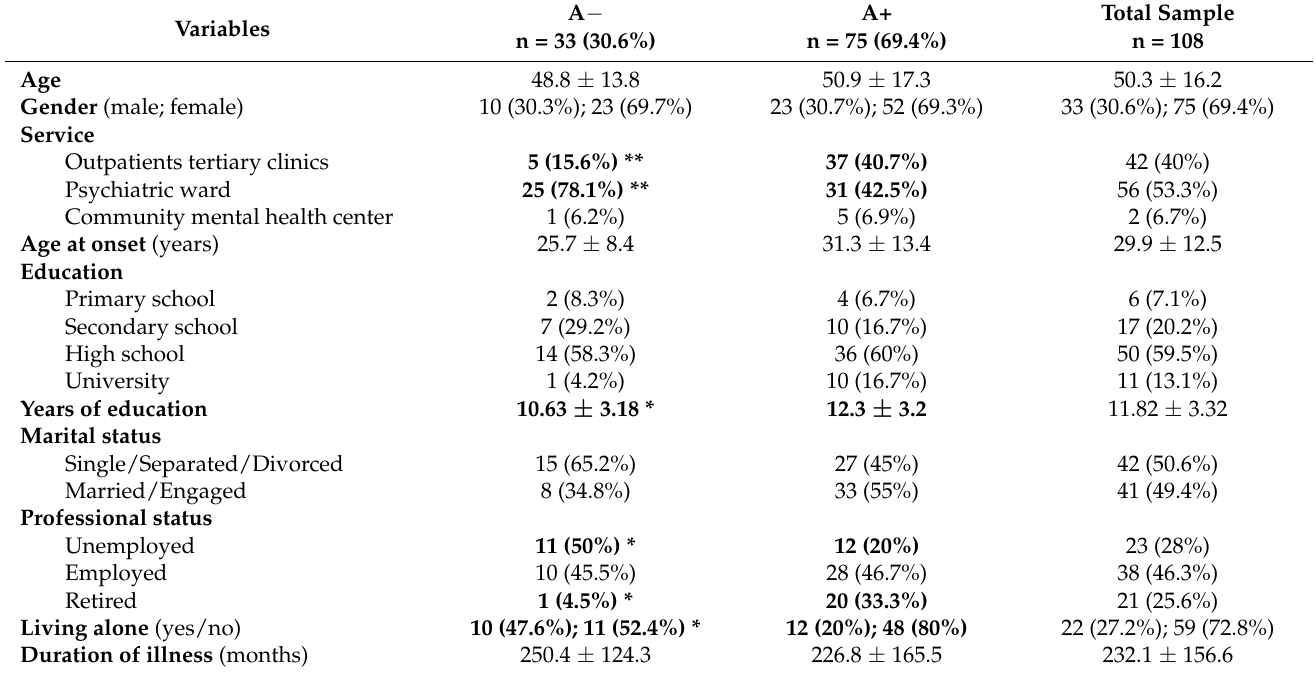
Table 1. Comparison of sociodemographic and clinical features between